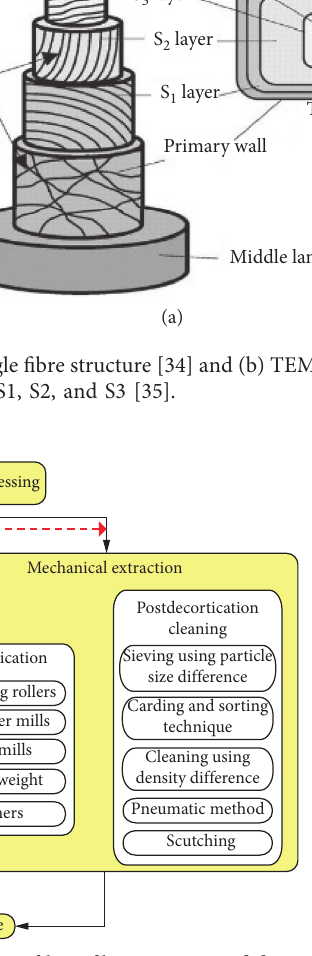
Figure 5: Schematic diagram of bast fibre processing